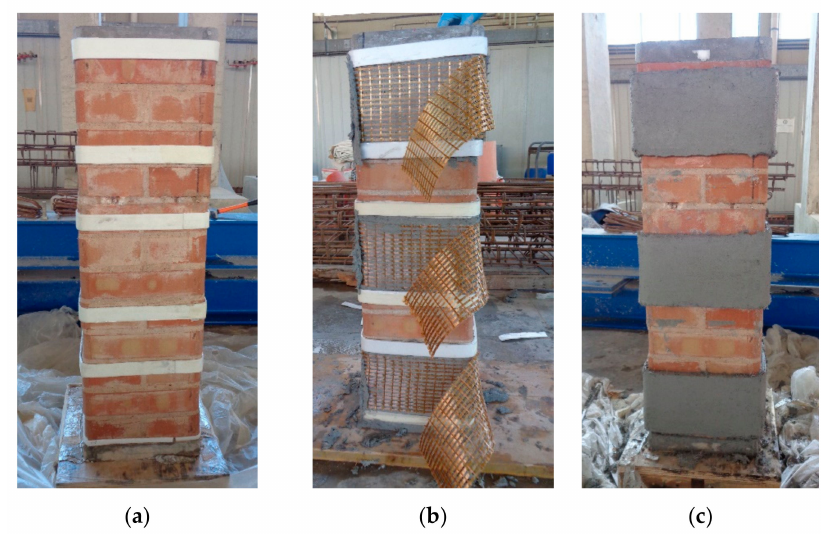
Figure 4. Confinement steps: ( a ) application of the internal mortar layer, ( b ) fabric mesh installation, and ( c ) application of the external mortar layer.